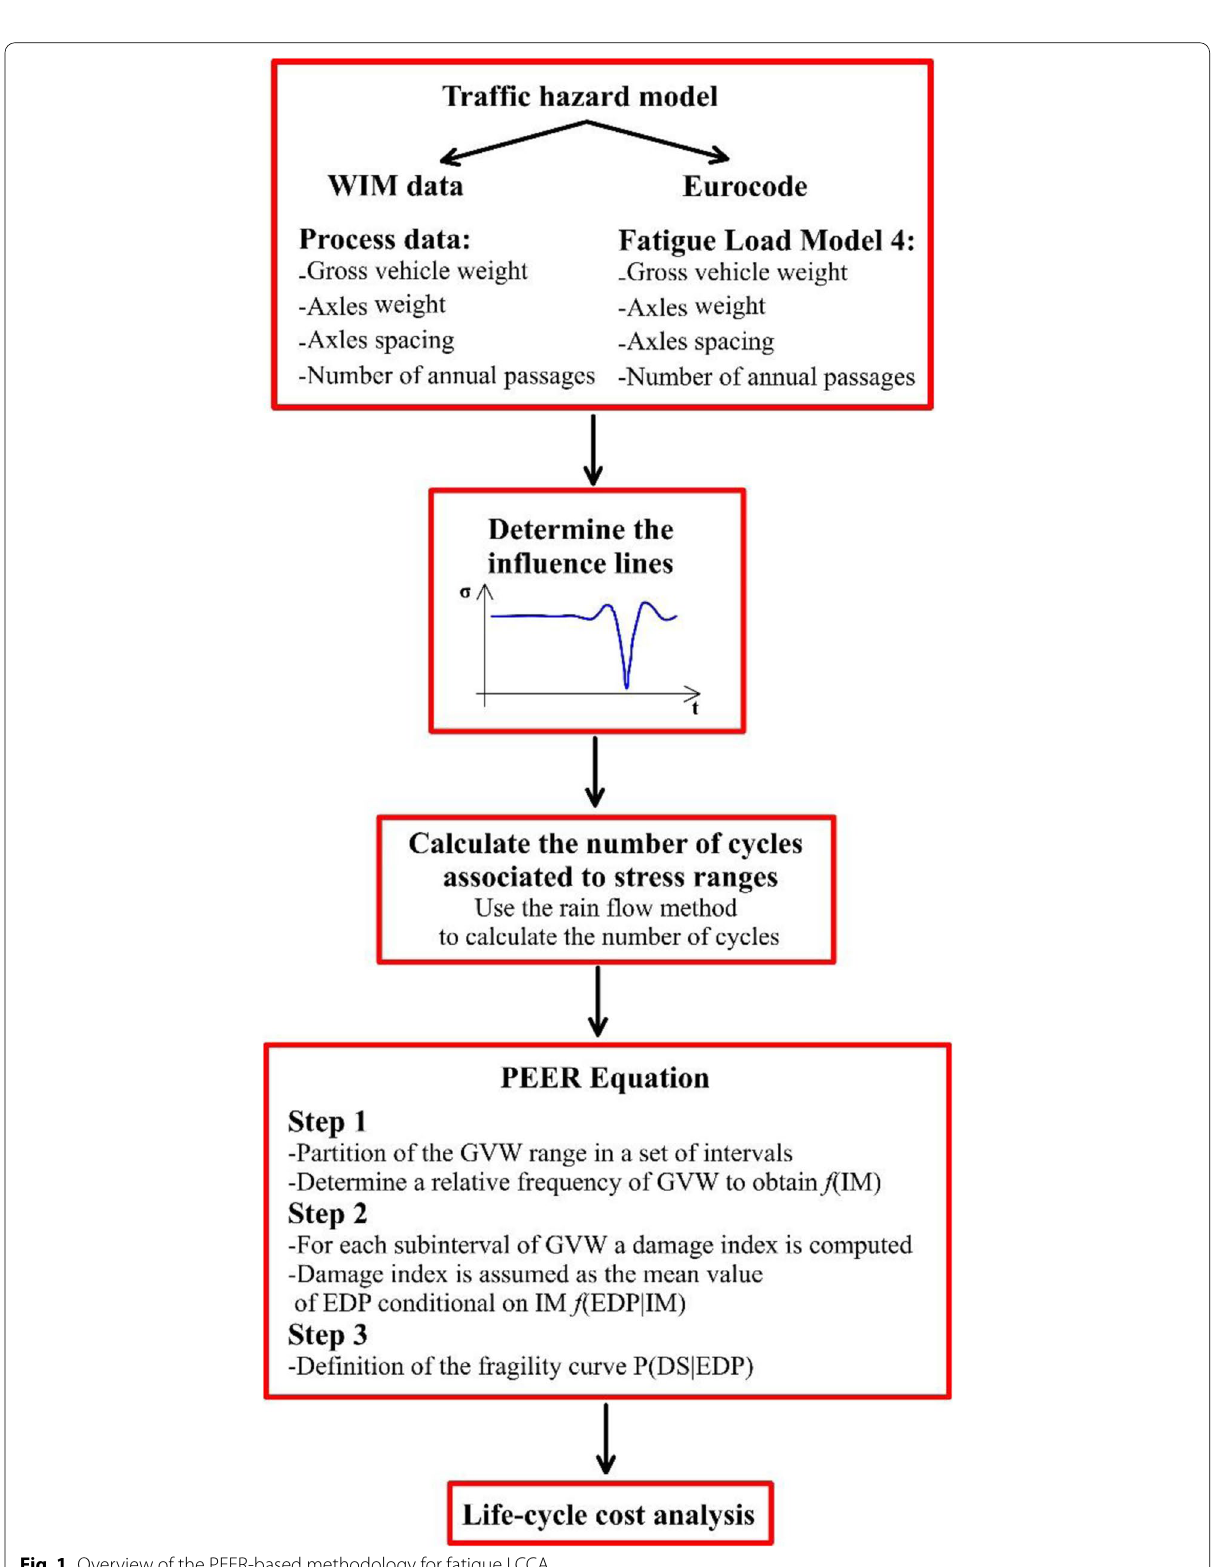
Fig. 1 Overview of the PEER-based methodology for fatigue